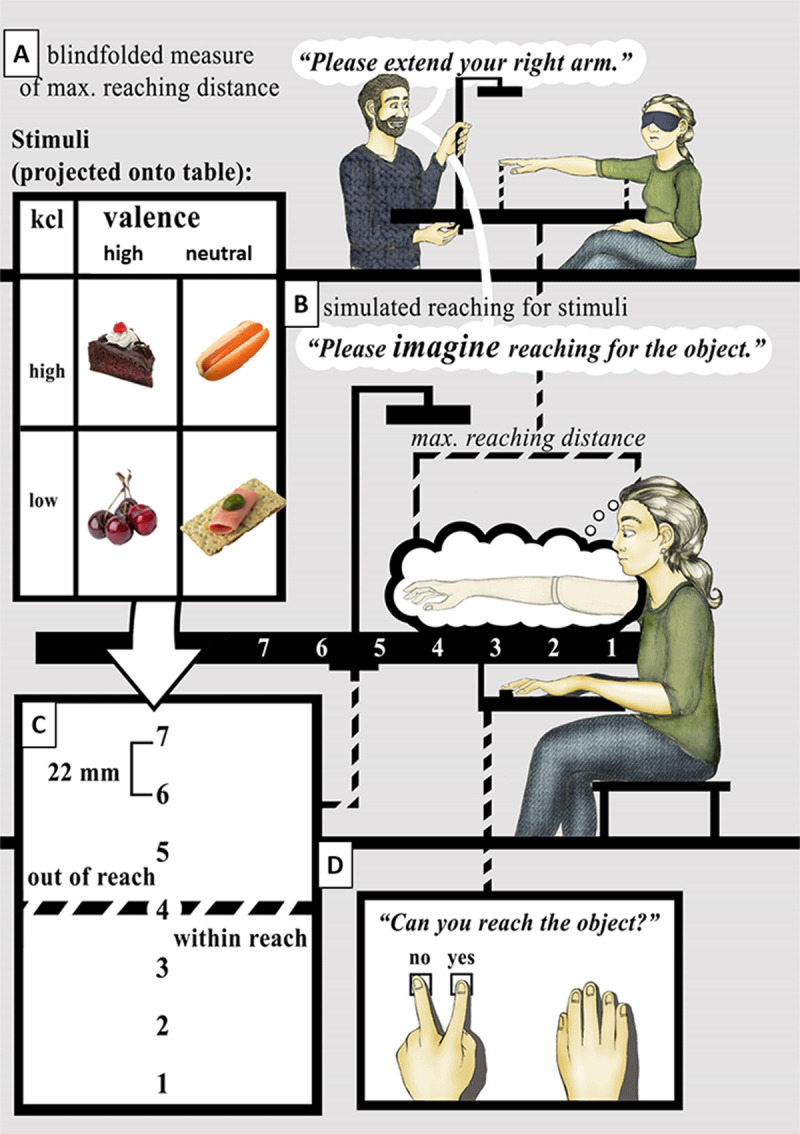
Experimental procedure. A) Participants extended their right arm (blindfolded) to establish their peripersonal space. B) They were reminded to keep this posture in mind when making their reachability judgments. C) Stimuli from different categories were presented at seven distinct positions; position four was aligned with the maximum extension of the right hand. D) Yes or no responses were performed by the left hand while the right hand remained stationary next to the keyboard below the table.